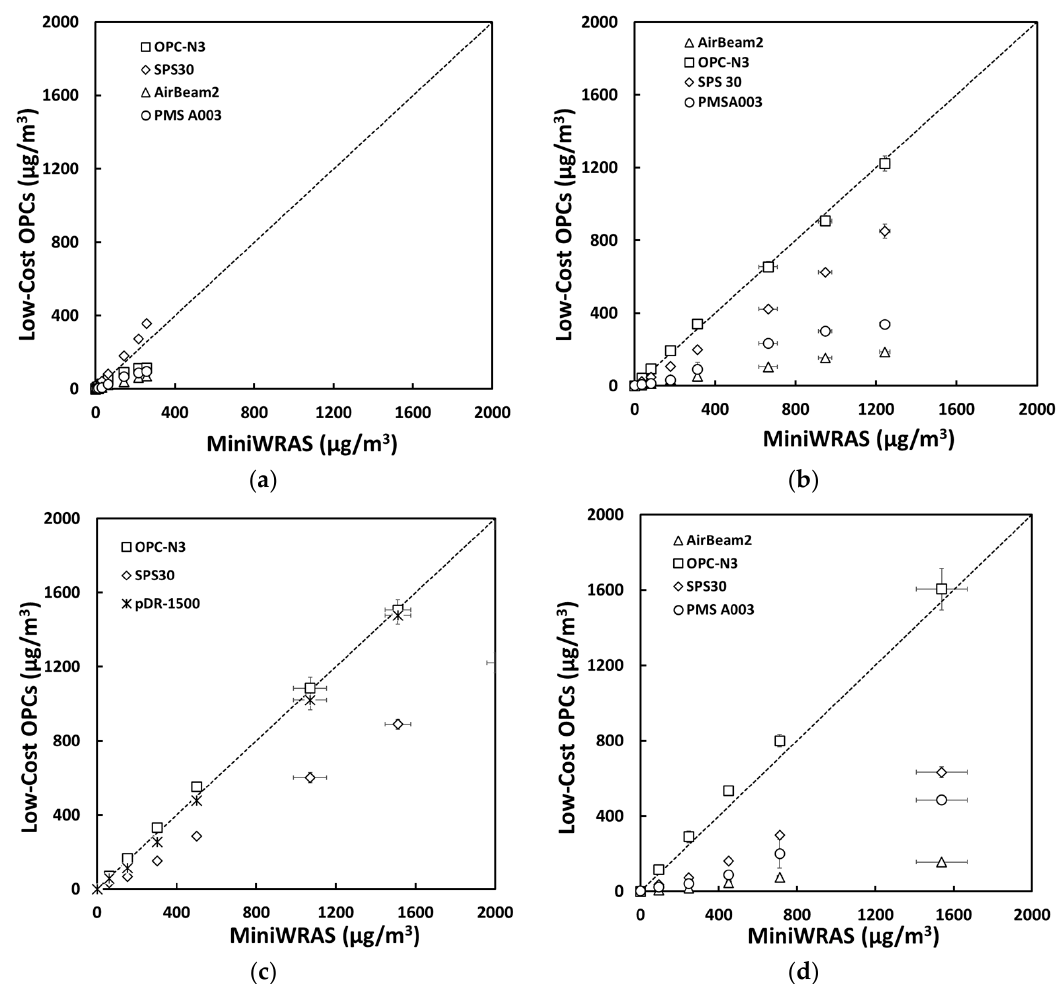
Figure 5. The mass concentrations (µg/m 3 ) of ( a ) PM 1 , ( b ) PM 2.5 , ( c ) PM 4 mc, and ( d ) PM 10 reported by the sensors plotted against the reference device for the ARD occupational experiment.